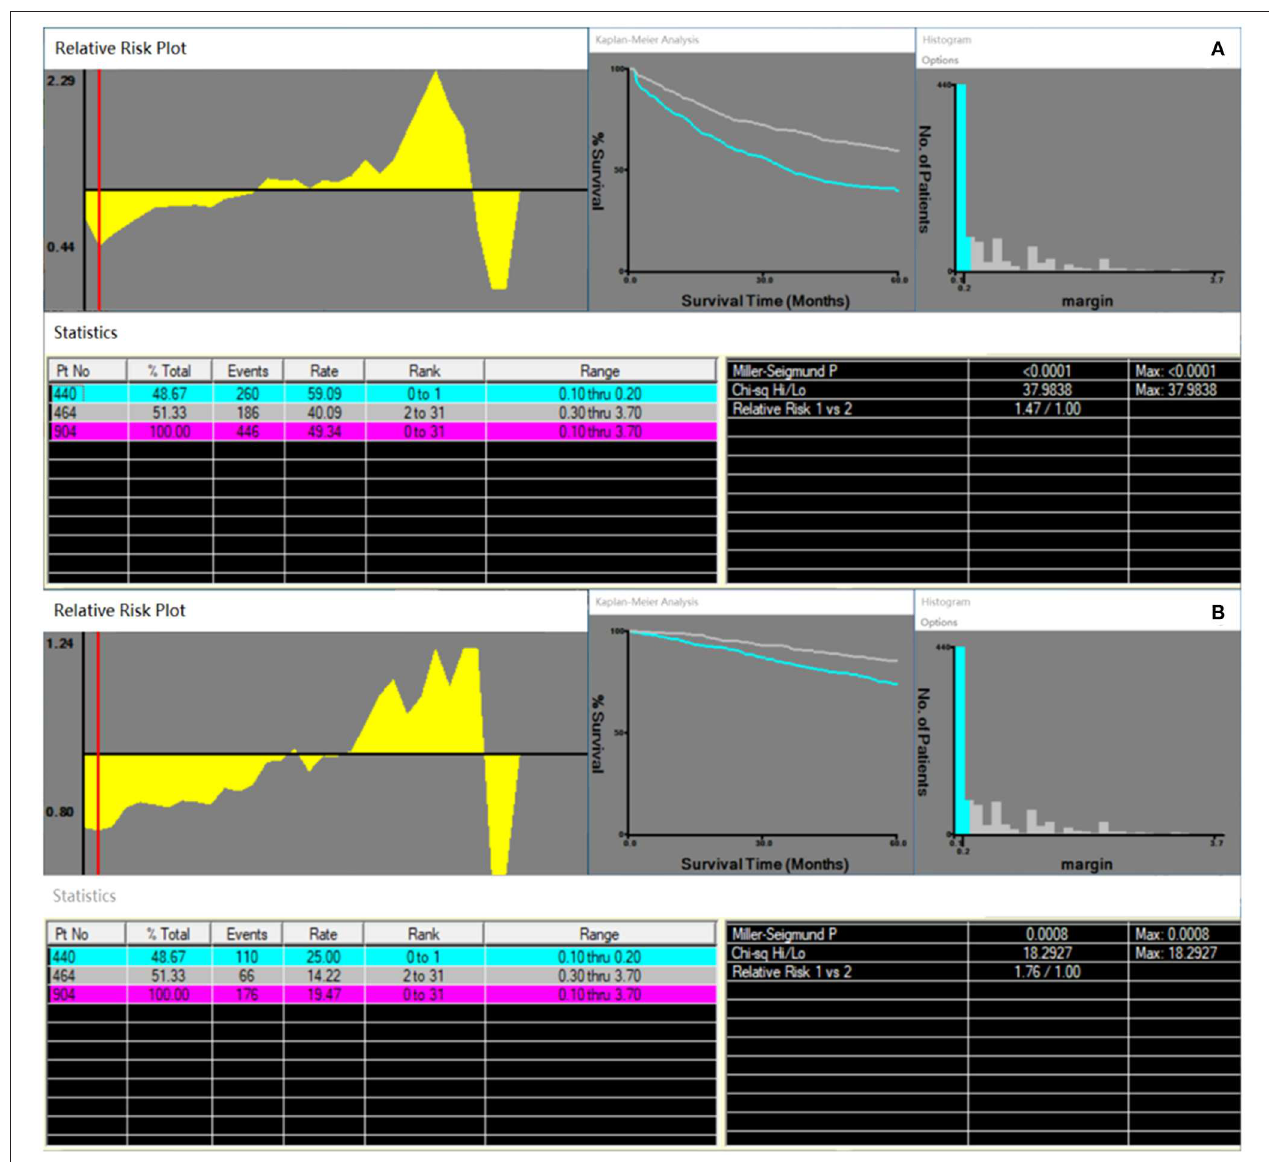
FIGURE 1 | Prognosis analyses by X-tile plot based on the distance of surgical margin. X-tile plots showing (A) recurrence-free survival; (B) overall